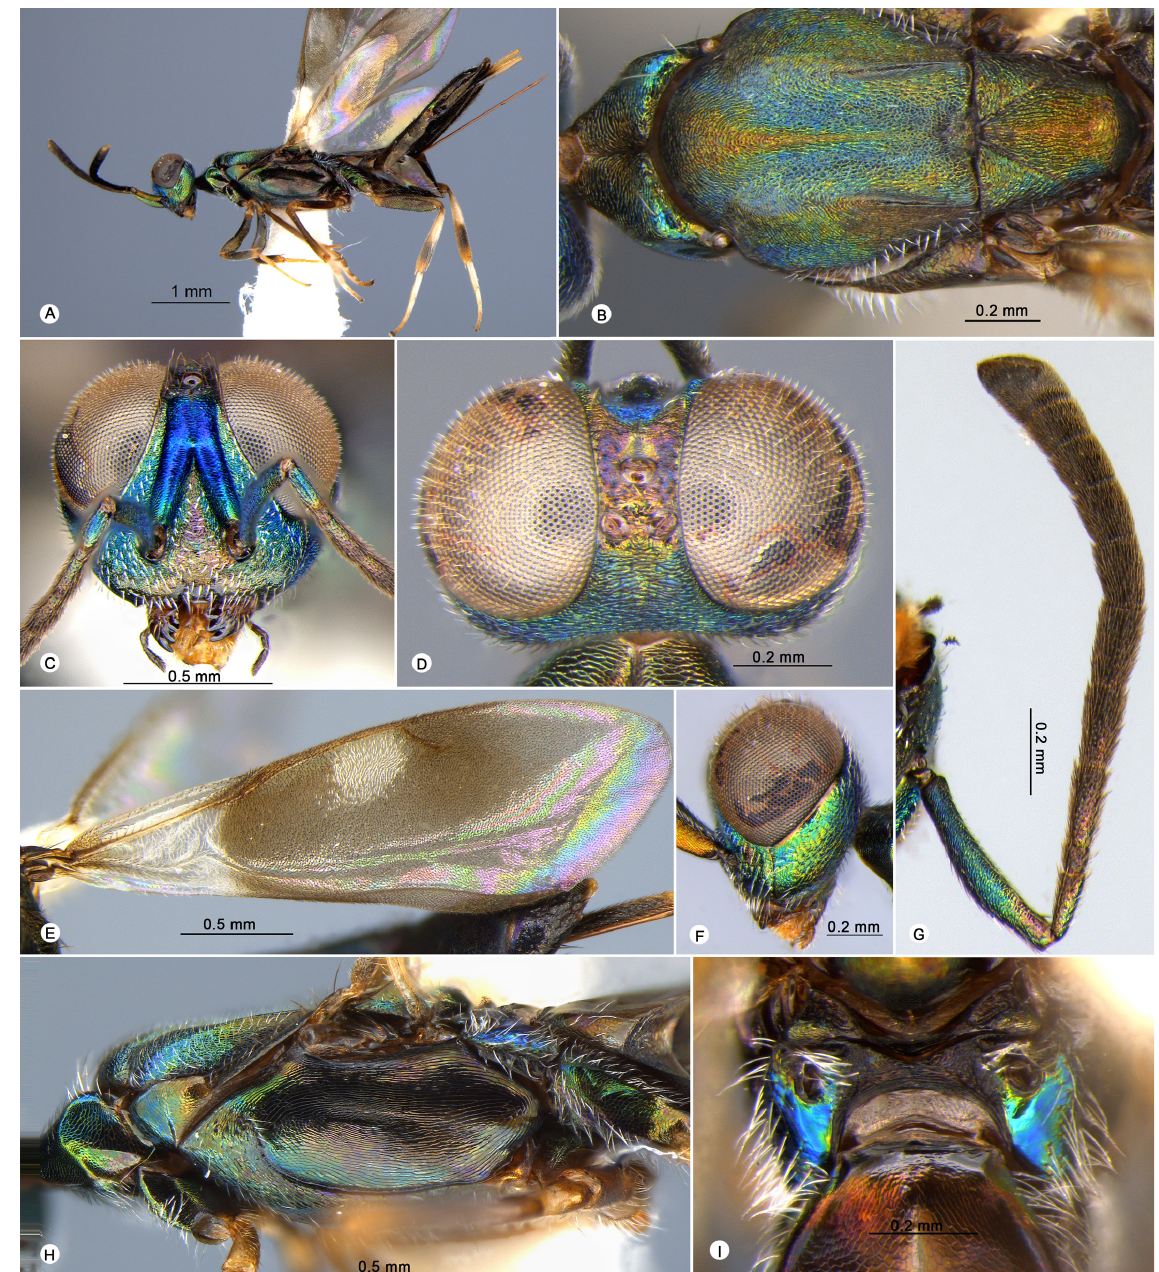
Fig. 6. Zaischnopsis zhongi Jiang & Peng sp. nov. A . Body, lateral view. B . Mesosoma, dorsal view. C . Head, front view. D . Head, dorsal view. E . Fore wing. F . Head, lateral view. G . Antenna. H . Mesosoma, lateral view. I .